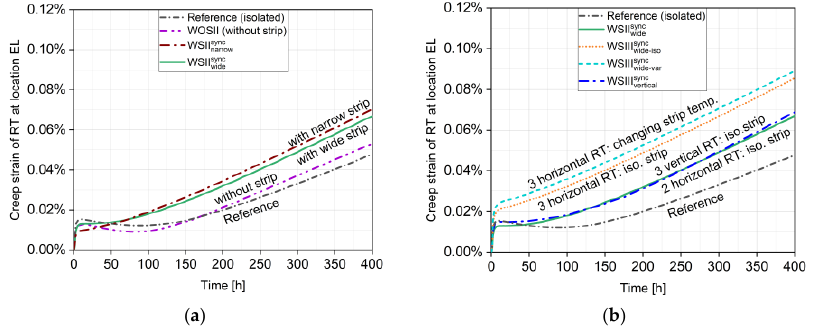
Figure 10. Creep strain magnitudes at location EL (= evaluation point on second elbow) for cases used to investigate the strip influence: ( a ) presence or absence of a strip; ( b ) different arrangements of two or three adjacent tubes.